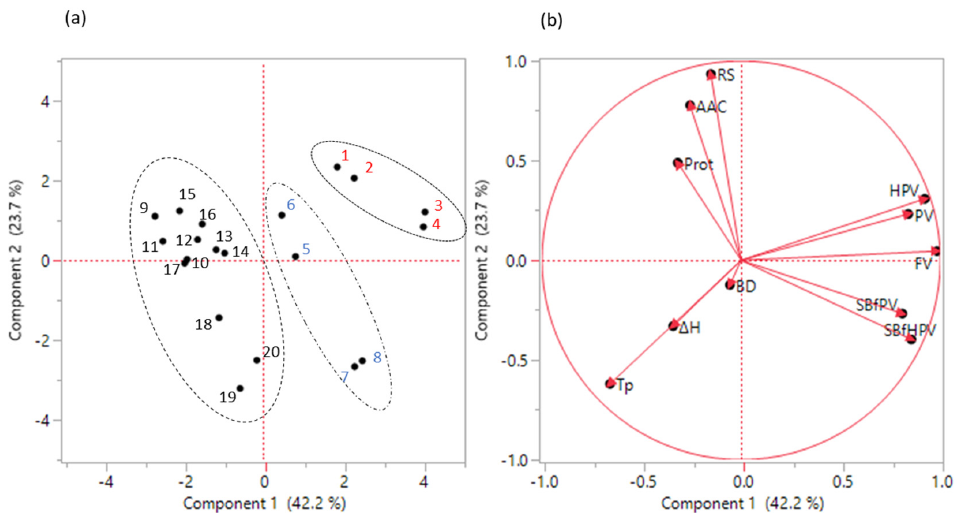
Figure 1. The score plot ( a ) and loading plot ( b ) of PCA analysis of grain functional traits and RVA parameters of 10 high AAC varieties grown in LA and AR. In ( a ), the numbers in red font (No. 1–4) are varieties in the T-TT haplotype, blue font (No. 5–8) are the T-GC haplotype, and black font (No. 9–20) are the C-GC haplotype. For variety names and growing states for these numbers, refer to Table 1. In ( b ), for trait abbreviations see Table 2.